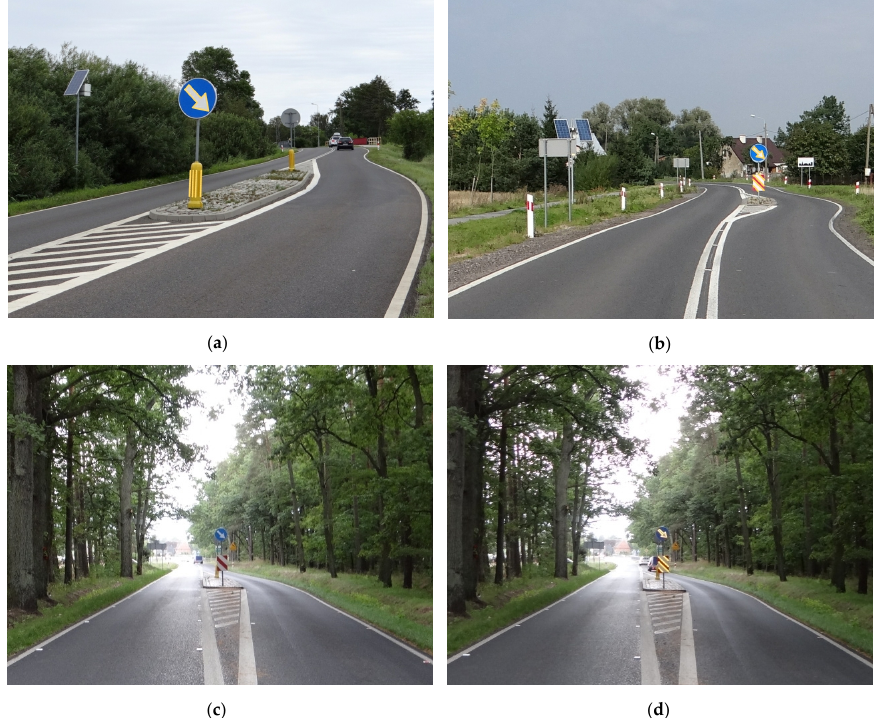
Figure 24. Application of the latest solar technology: ( a ) solar panel powering the LED arrow on bollards U-5 and C-9; ( b ) solar panel illuminating LED lines on the striped bollards D-6a and C-9; ( c ) view of unilluminated signs D-6a and C-9; ( d ) view of signs D-6a and C-9 illuminated with LED lights. Additional solar elements installed in the face of the entrance island, on the outer edge of the carriageway and on the guide posts (Figure 25) are another element related to energy conservation in village environments evidently contributing to the reduction of vehicle speeds in village transition zones. They are recommended by the authors for use in particular in transition zones situated in forest terrain. These are SolarCAP elements, i.e., self-contained LED lighting devices. They are not equipped with additional batteries, which makes them less expensive, and apart from contributing to conservation of energy they also reduce construction and maintenance costs and improve traffic safety owing to their better visibility, and hence a greater impact on drivers’ perception. They are SolarCAP devices are maintenance free for at least 10 years from installation. They are resistant to